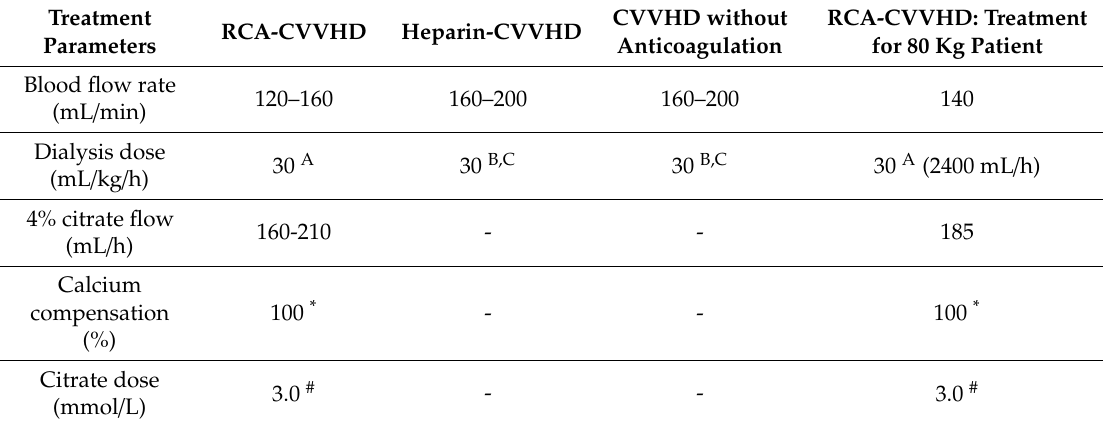
Table 1. Protocol parameters for the use of Septex with Prismaflex § .